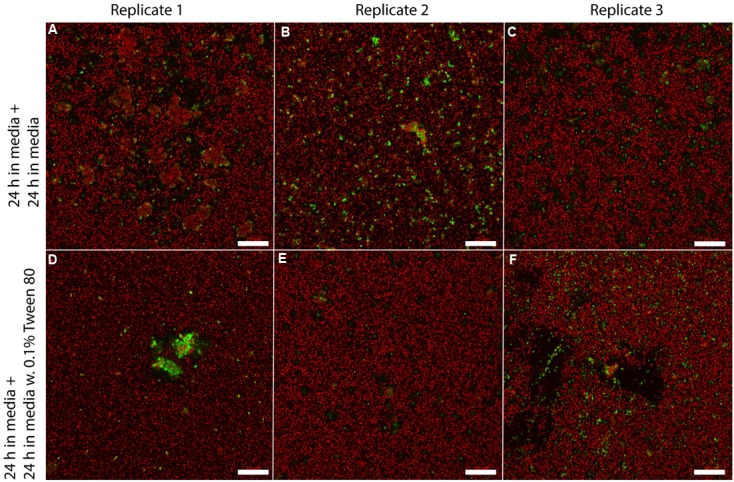
Confocal laser scanning microscopy images of three replicate S. aureus biofilms grown for 48 h in TSB media and transferred to either fresh media (A–C) or 0.1% Tween 80 (D–F) followed by growth for 24 h. SYTO 60 (red) stains living bacteria while TOTO-1 (green) stains dead bacteria and extracellular DNA. Scale bar = 20 μm.